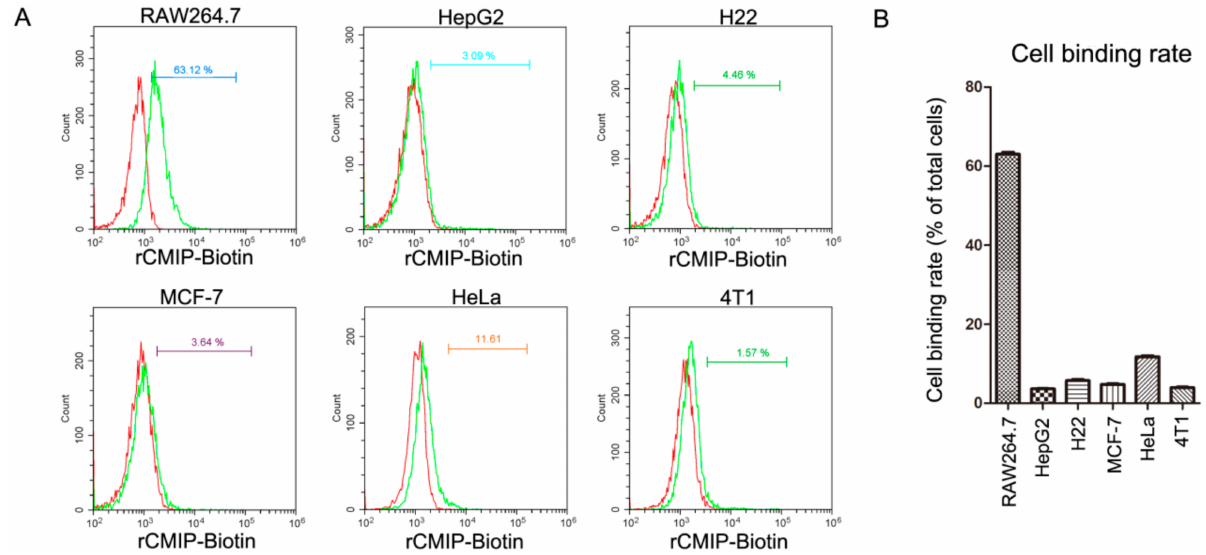
Figure 2. Cell binding selectivity of rCMIP. ( A ) RAW 264.7, HepG2, H22, MCF-7, HeLa and 4T1 cells (1 × 10 6 ) were incubated with biotinylated rCMIP (2.5 µ M) at 4 ◦ C for 2 h. After washing, cells were incubated with streptavidin-FITC (SA-FITC) and analyzed by flow cytometry. Results are representative of three independent assays. ( B ) The cell labeling ratio quantitation of the tested cells from the flow cytometry results. All the data are presented with means ± SD ( n = 3).